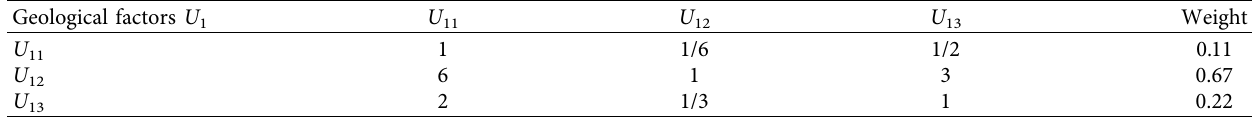
Table 3: Judgment matrix table U